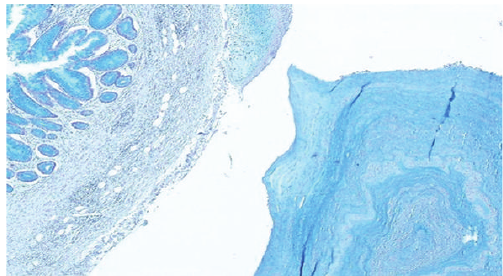
Figure 2: Alcian Blue positive staining of the globules, adjacent luminal mucin and mucosa (Alcian Blue pH 2.5,